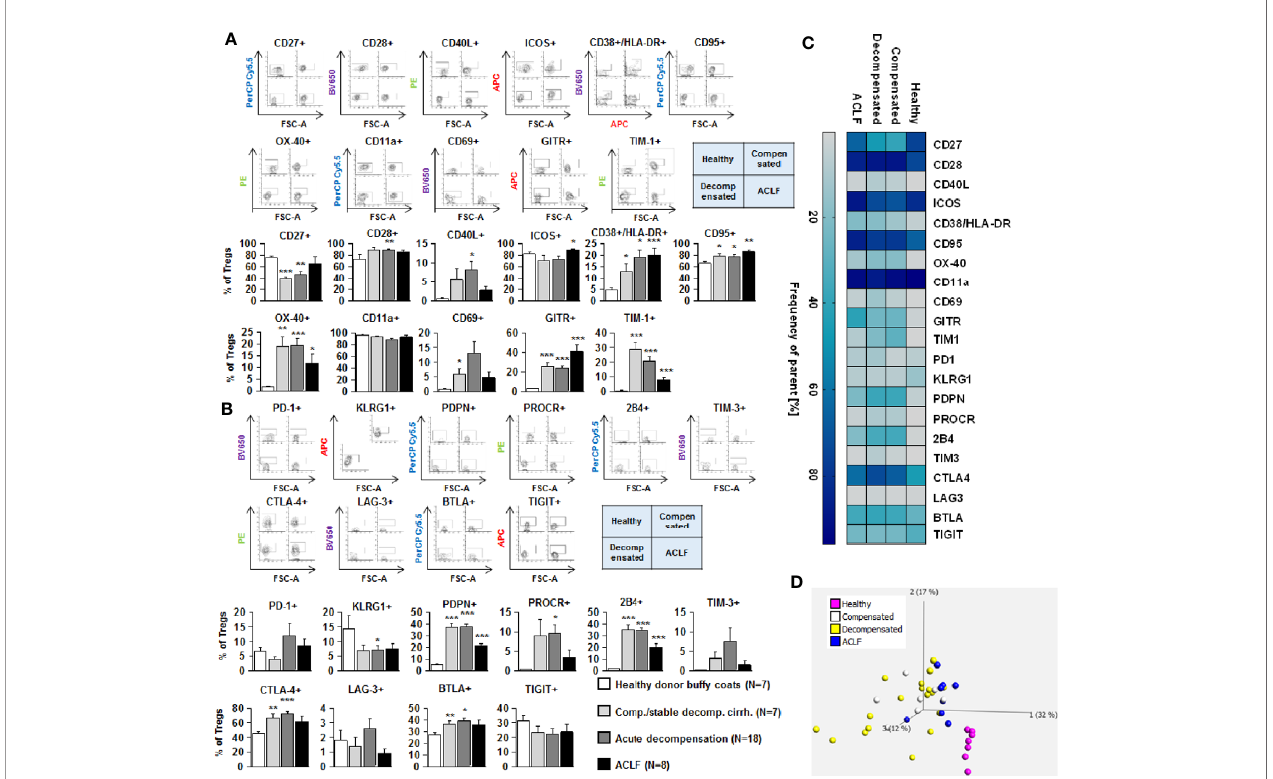
FIGURE 5 | Parallel upregulation of co-stimulatory and inhibitory immune checkpoints on CD4+ regulatory T cells during the course of liver cirrhosis. Expression of co-stimulatory immune checkpoints, T cells activation markers (CD38/HLA-DR, CD69) as well as of the Fas-ligand CD95 on regulatory (CD4+ CD25dim CD127-) T cells are shown in (A) , while expression of inhibitory immune checkpoints is shown in (B) . Typical examples of dotplots of fl ow cytometric analysis of healthy controls or patients with compensated liver cirrhosis, decompensated liver cirrhosis or ACLF are shown in the upper panels whereas mean values and standard deviations are shown in graphs in lower panels. (C) Heatmap summarizing the mean frequencies of positive cells. (D) Principle component analysis of the assessed markers showed distinct clustering of patients with liver cirrhosis versus healthy controls whereas no clear clustering was observed between the stages of liver cirrhosis. Values are displayed as frequency of parent. * P <0.05, ** P <0.01, *** P